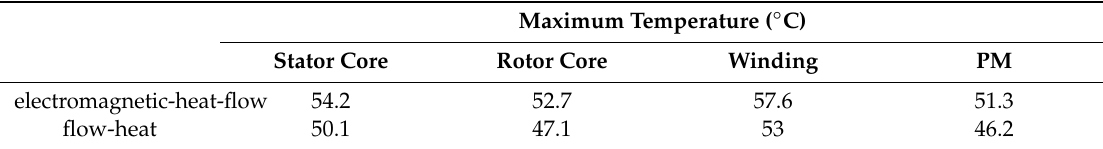
Table 4. Comparison of IWM maximum temperature.